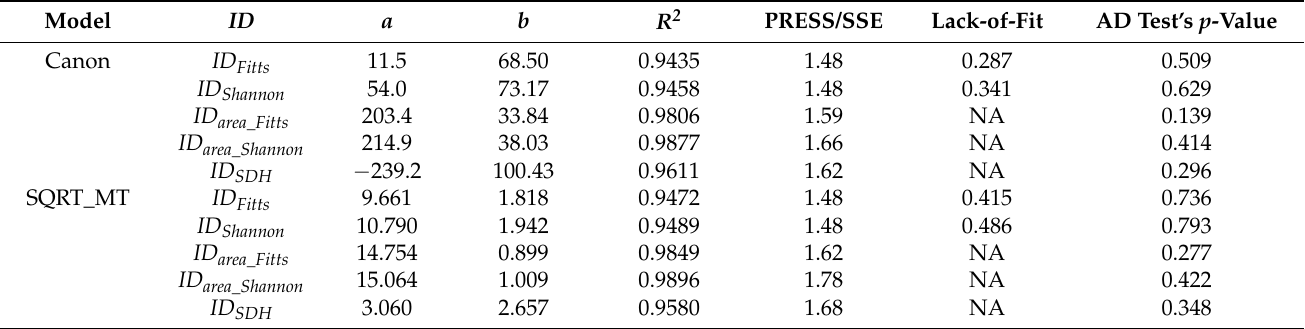
Table 1. Regression analysis of 2D target shapes data in Experiment 1 of Sheikh and Hoffmann [15]. ID area_Shannon had the best R-square in both the Canon and SQRT_MT models.